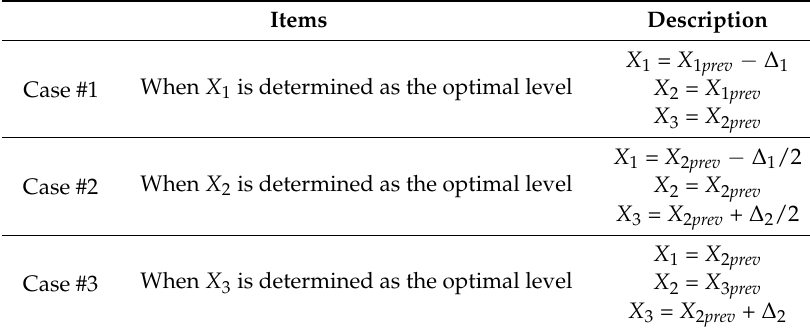
Table 2. Definition of new level